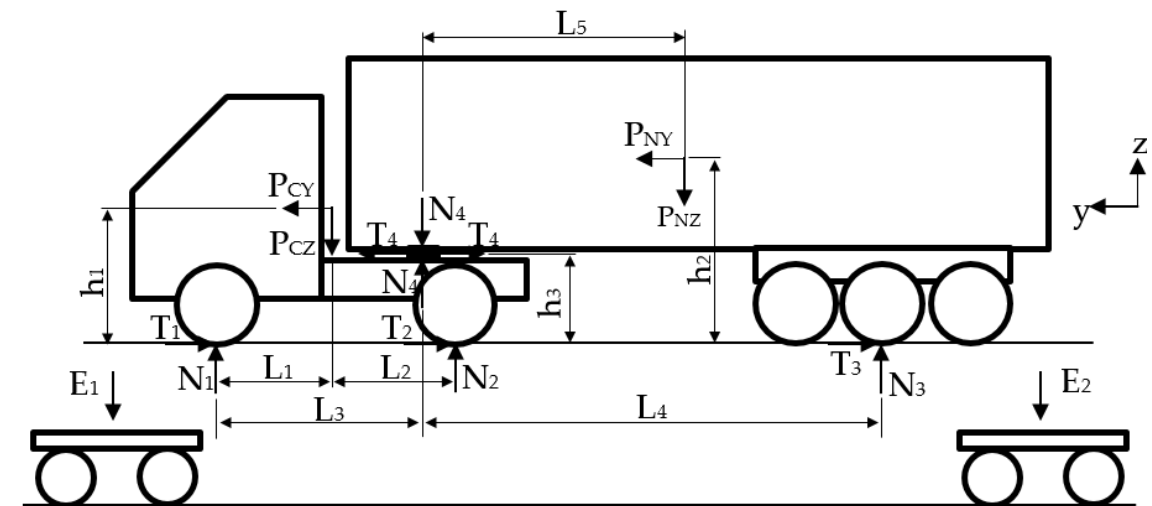
Figure 2. Road vehicle interactions with the wagon platform, based on [18], N i ,T i —normal and tangential forces, P i —inertia forces, E i —vertical force at the railway bogie centre pivot.